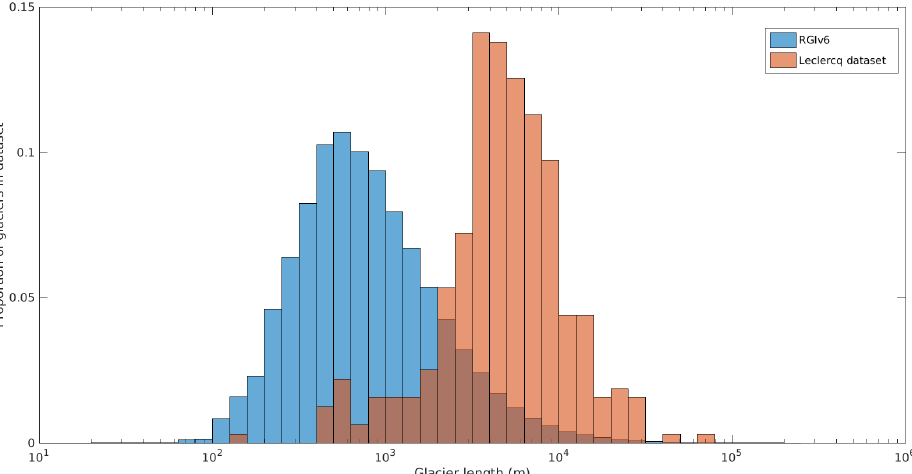
Figure 1. Distribution of 1950 Leclercq et al. (2014) dataset glacier lengths (for the 412 glaciers that are matched with RGIv6 glaciers) vs. distribution of RGIv6 most up-to-date glacier lengths. Relative frequency is used due to the orders-of-magnitude level difference in glacier numbers in each dataset.